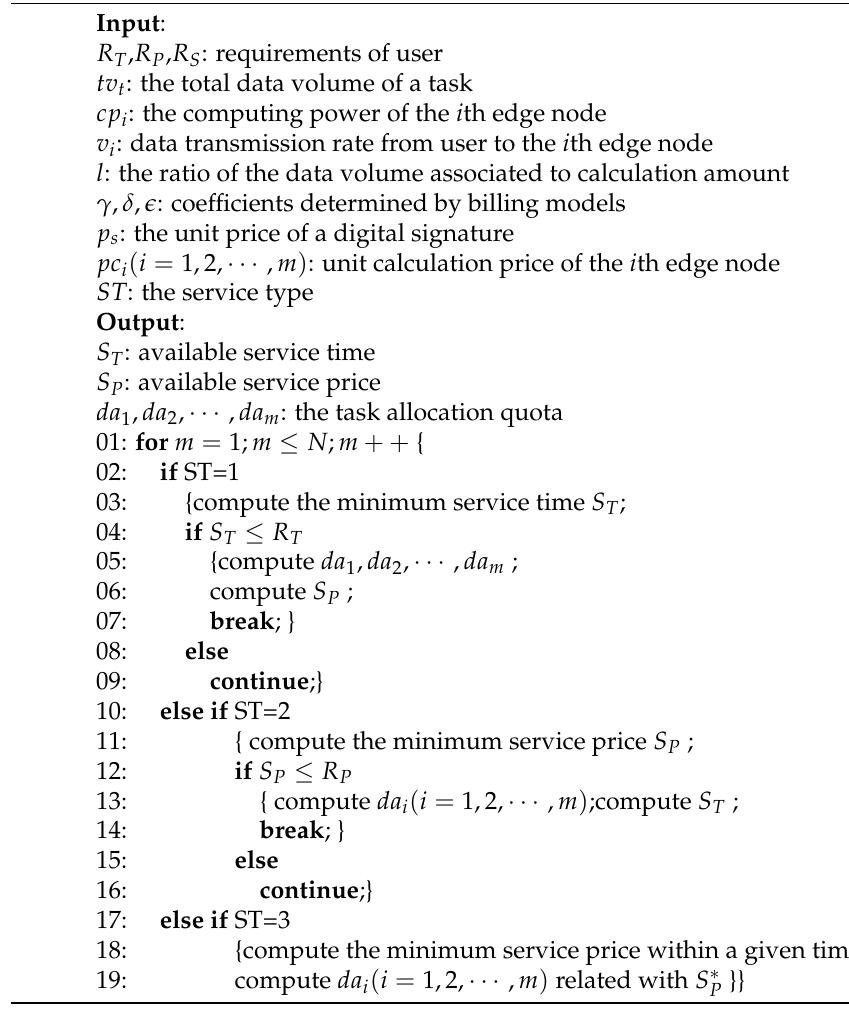
Algorithm 2 : Service estimation and resource allocation